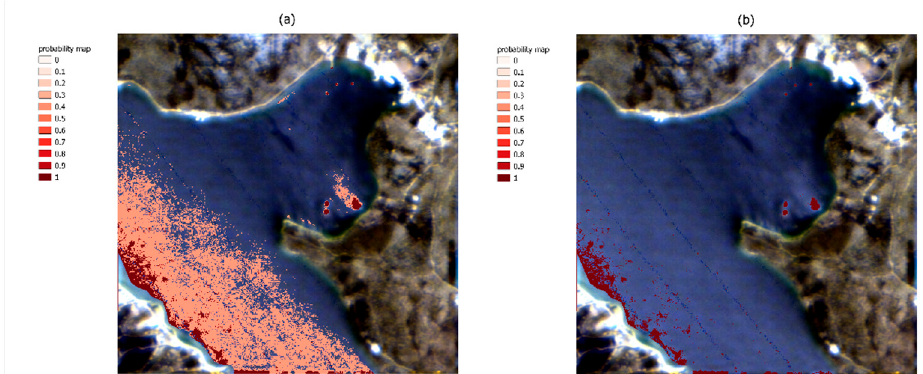
Figure 9. Results of the applications of the supervised and unsupervised ML algorithms trained during the configuration phase and applied on the PRISMA image collected on 23 June 2021 over the Geras Gulf. ( a ) The probability map ranges between 0 and 1. ( b ) The probability mask with only values greater than 0.80.